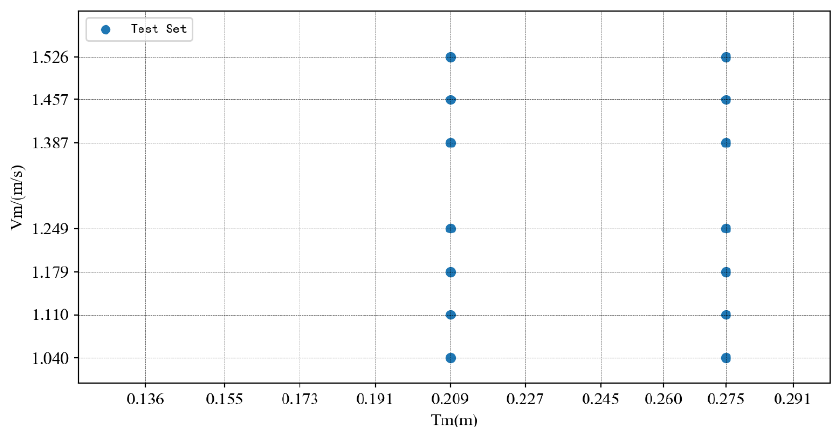
Figure 5. The distribution of test set samples for interpolation prediction. In the extrapolation prediction, the model ship data at draft = 0.136 m and draft = 0.291 m are taken as the test set. The distribution of the test set is shown in Figure 6.